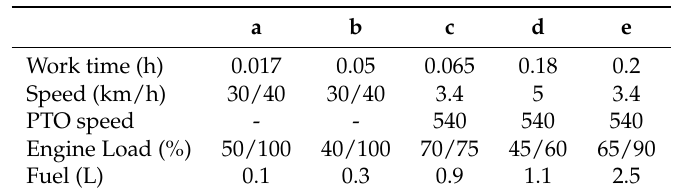
Table 2. Tasks experimental characterization overview: (a) Trailer 6000 kg; (b) Trailer 1400 kg; (c) Atomizer; (d) Shredder; and (e) Rotary harrow.